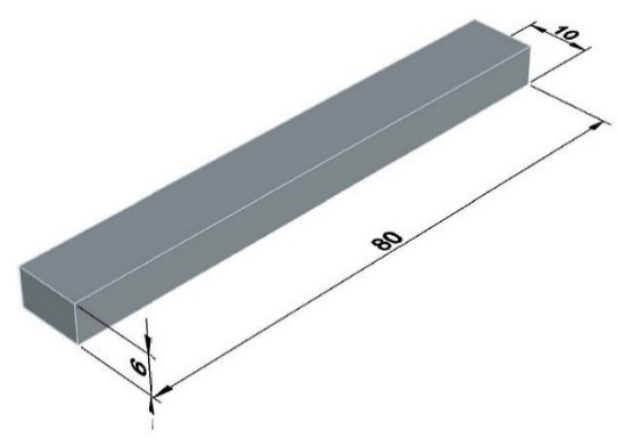
Figure 4. Isometric view of the Charpy specimen.